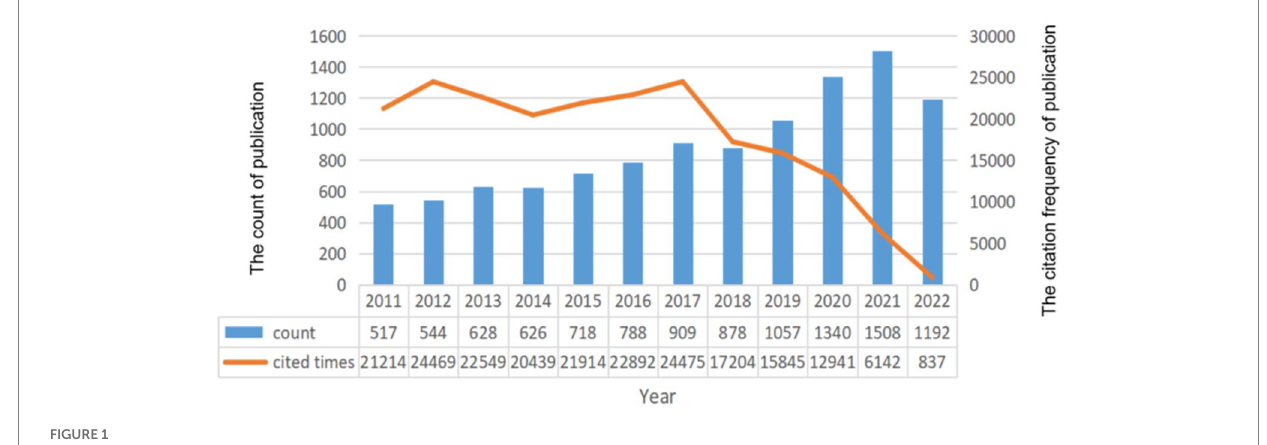
FIGURE 1 Distribution of annual years.